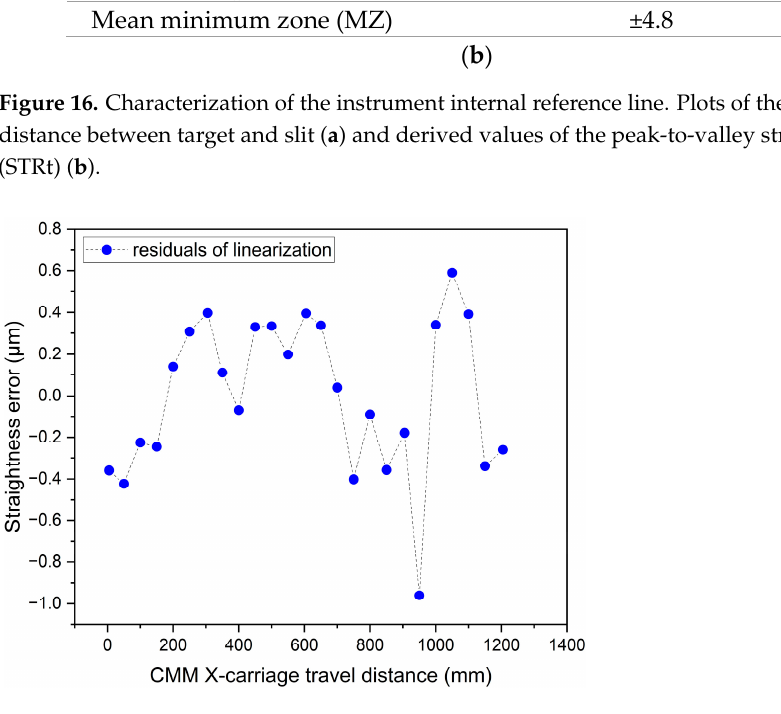
Figure 17. Straightness of the CMM table stroke. The least-squares reference line was subtracted and the stroke is represented as the horizontal axis. the stroke is represented as the horizontal